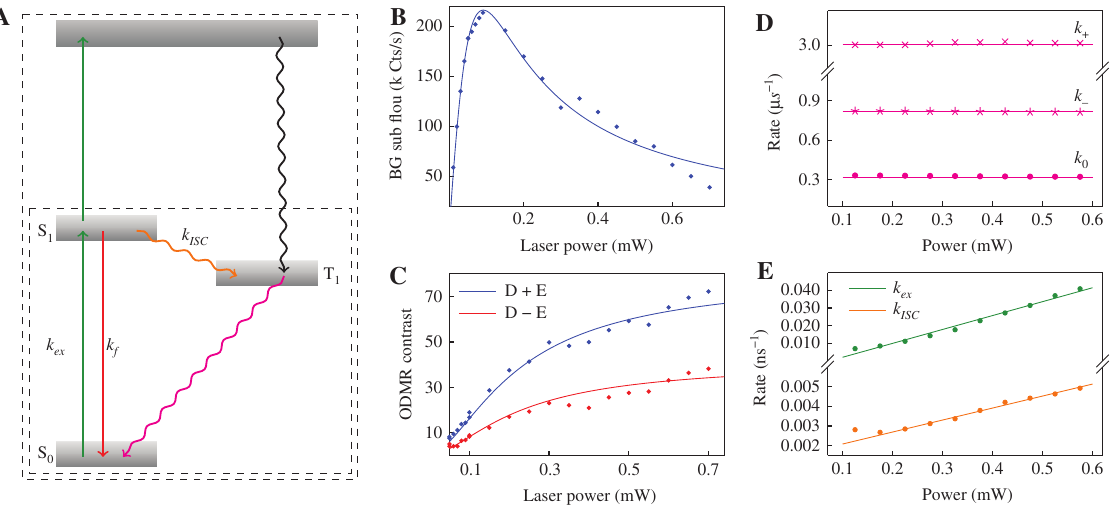
Figure 4: The power dependent optical dynamics of the ST1 center. (A) A proposed level scheme that could explain the power dependence of the optical dynamics. It includes a second manifold of excited levels that are either internal defect levels or photoionized levels. The remaining subfigures show the optical dynamics as a function of pump power. The solid lines represent a fit using the rate equation model in equation (2). (B) Depicts fluorescence counts. The solid lines represent the fit using the extended rate equation. (C) Shows ODMR contrast. (D) Is the depopulation rates from the triplet levels. (E) Shows optical excitation rate k (green) and the upper intersystem crossing rate k ex ISC